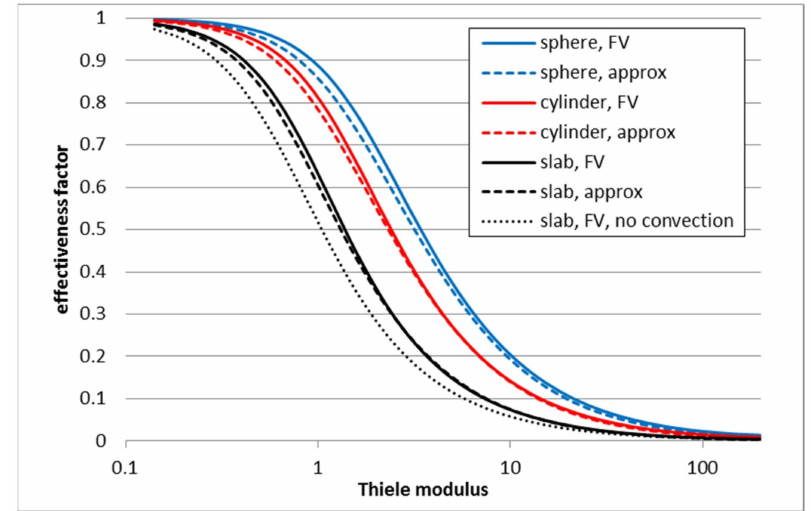
Figure 4. Effectiveness factors for second order elementary reactions in three geometries with finite volume and approximate method. Effectiveness factor for slab when convective flux is neglected is shown for